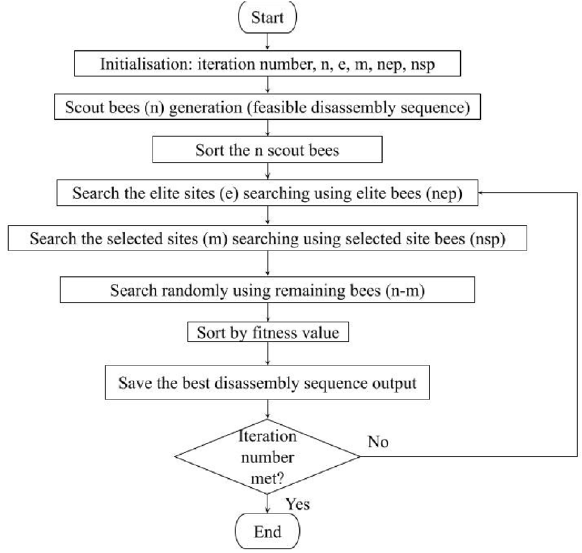
Figure 3. Flow chart of the Bees Algorithm used in the DT 23